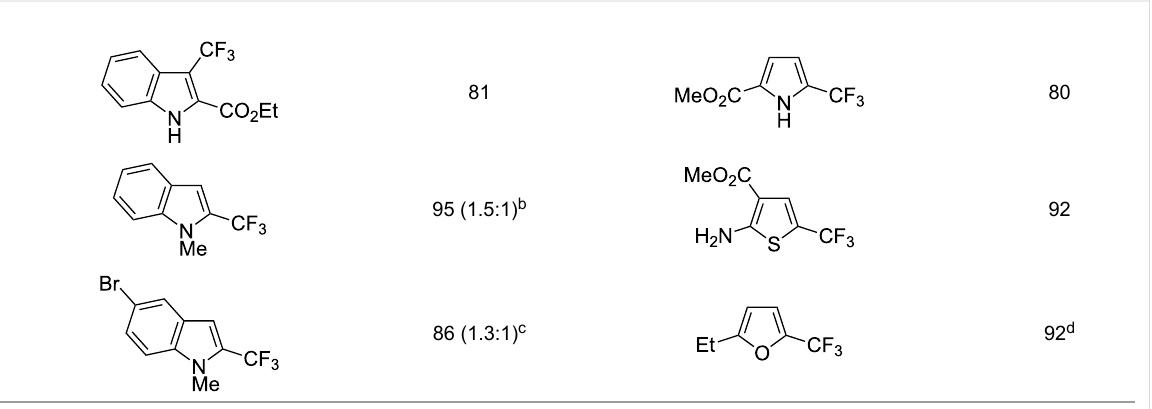
Table 33: Trifluoromethylation of indoles with trifluoromethyl iodide under Ru-based photoredox catalysis [107].